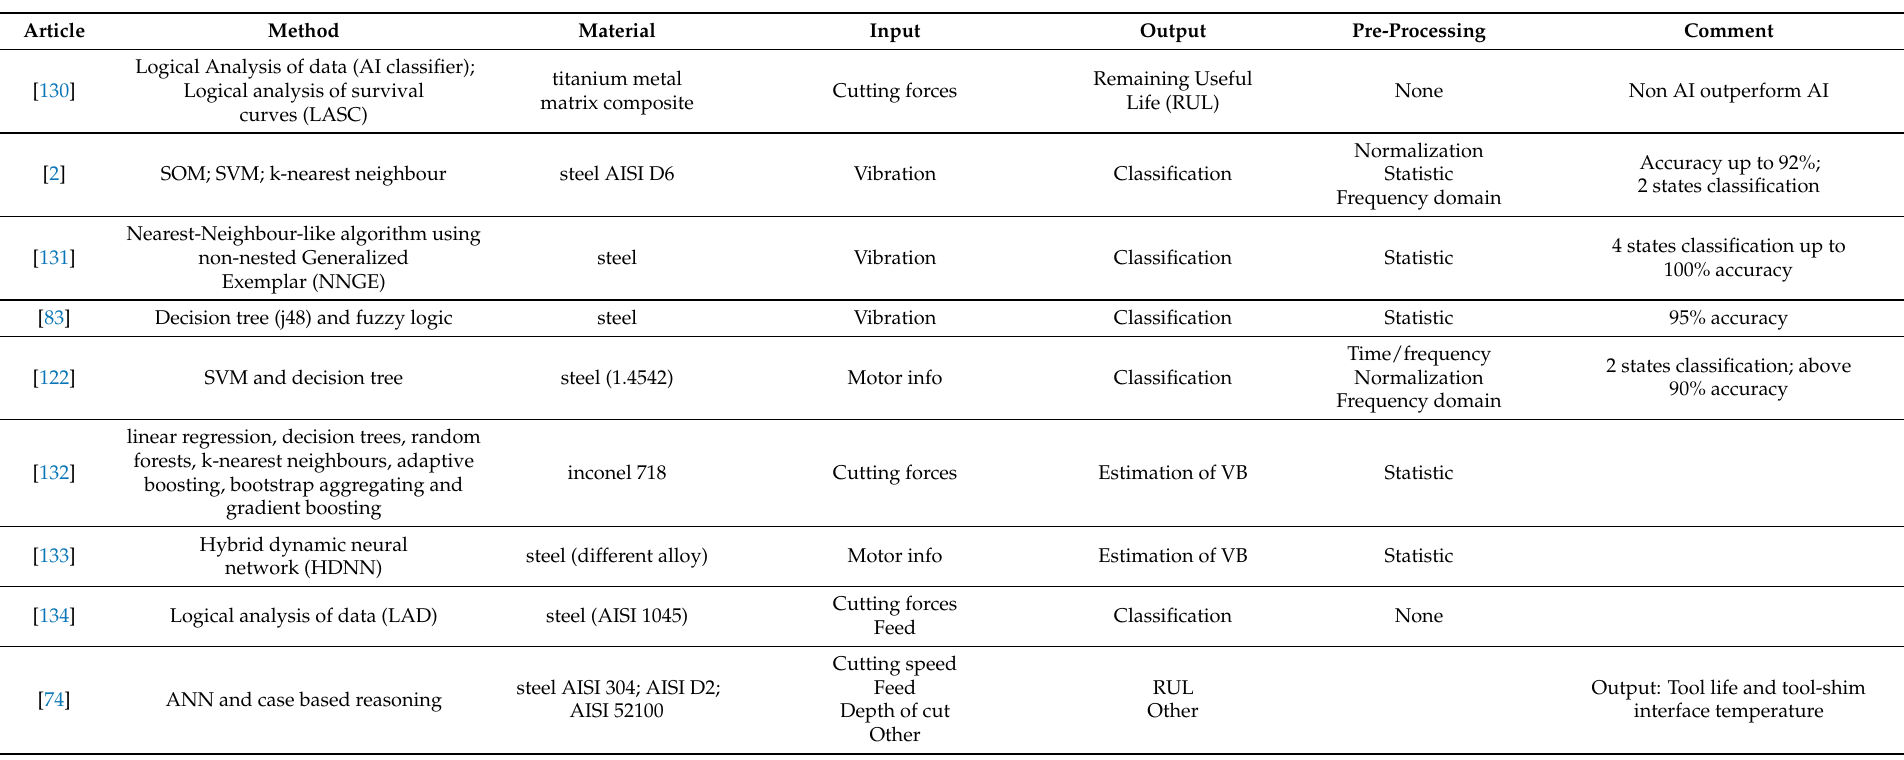
Table A8. General summary of publications related to various other